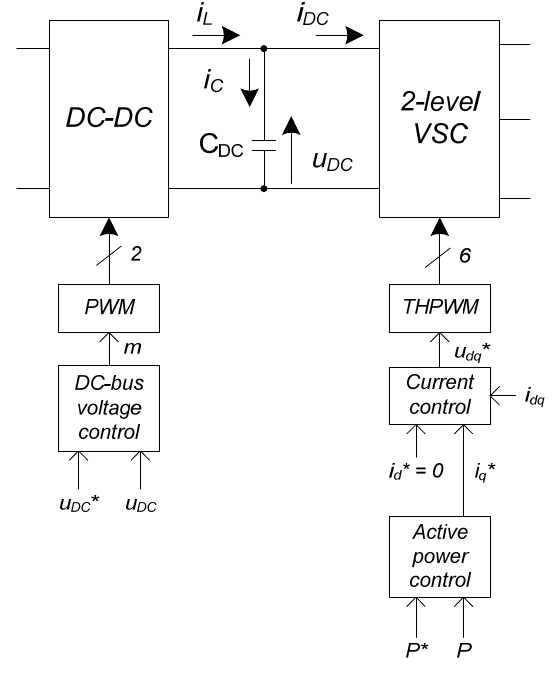
Figure 7. Overview of the control system of the power conditioning system based on a two-level